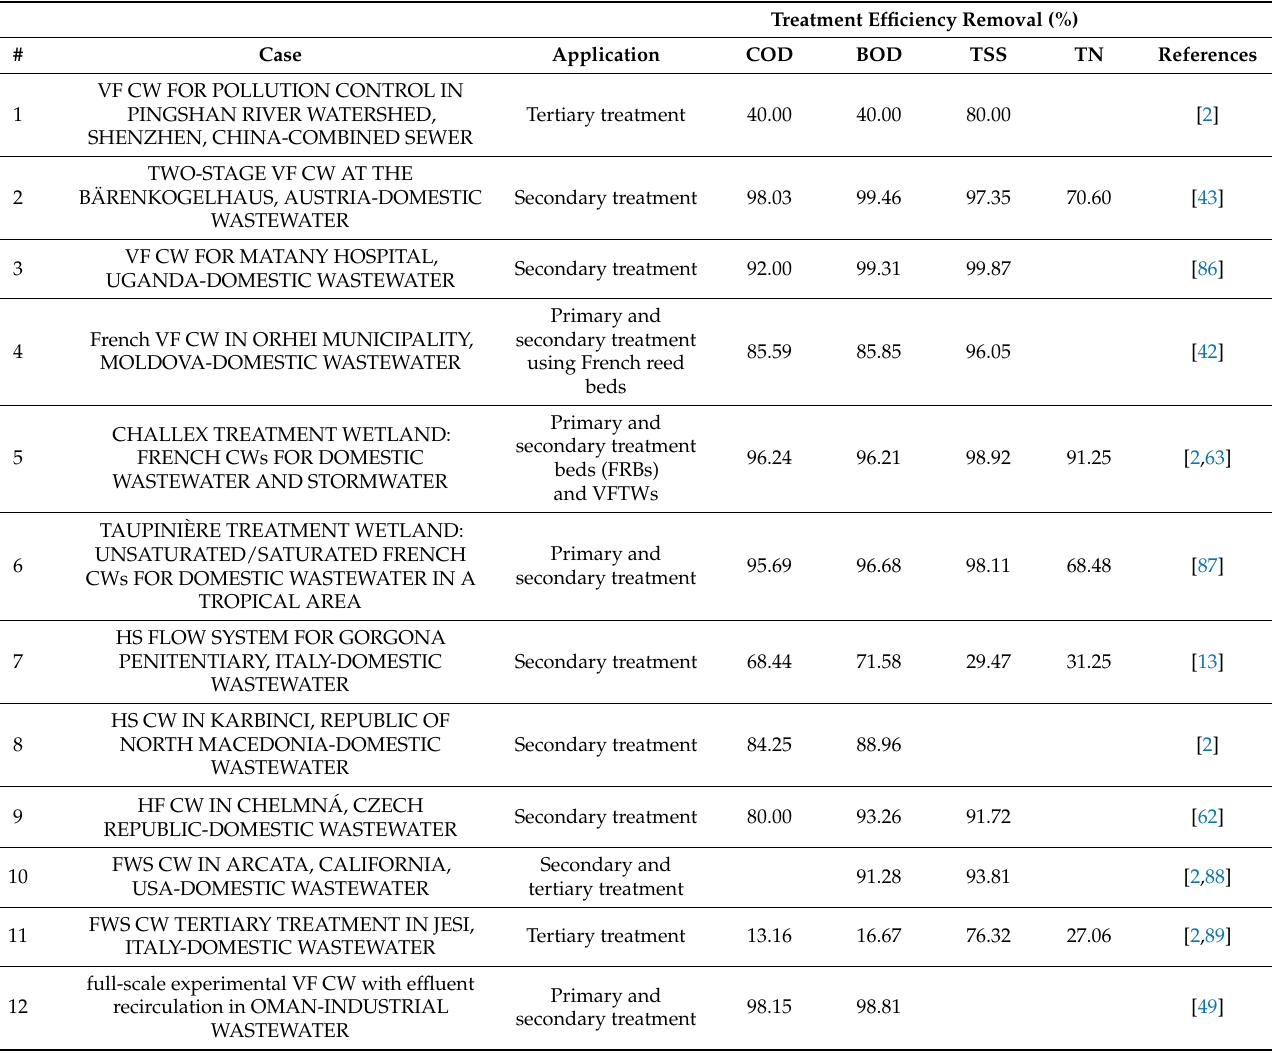
Table A1. Applications and examples of